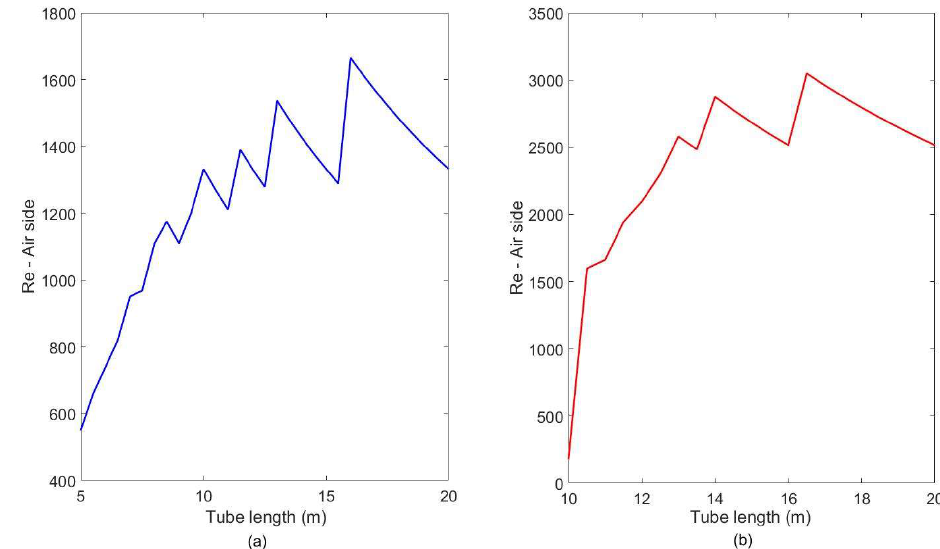
Figure 9. Reynolds number air side ( a ) outside diameter of 7.35 mm; and ( b ) outside diameter of 18.5 mm.